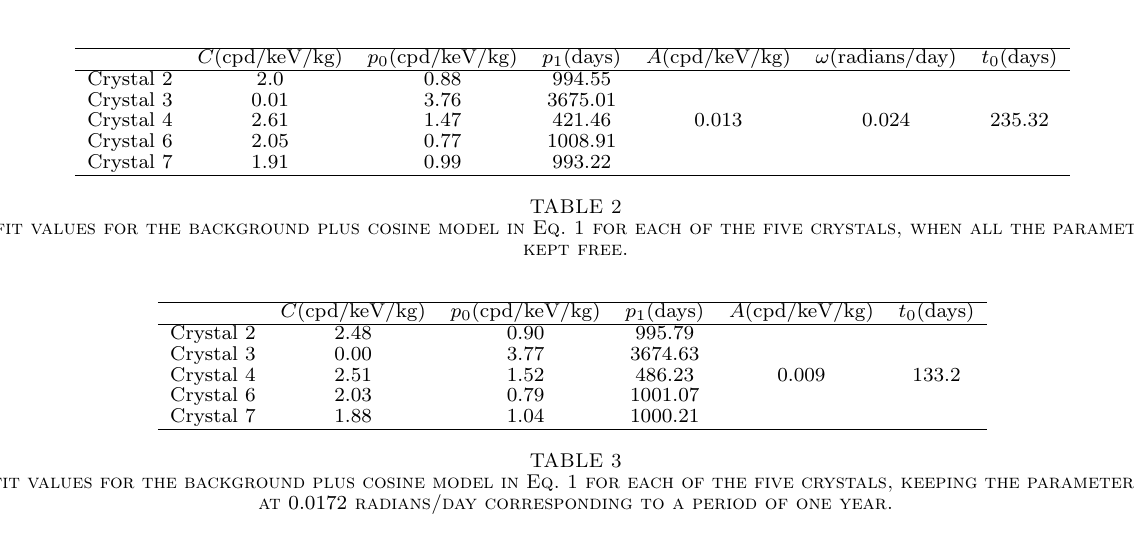
TABLE 1 Best-fit values for each of the five crystal for the background-only model, consisting of the first two terms in Eq. 1.